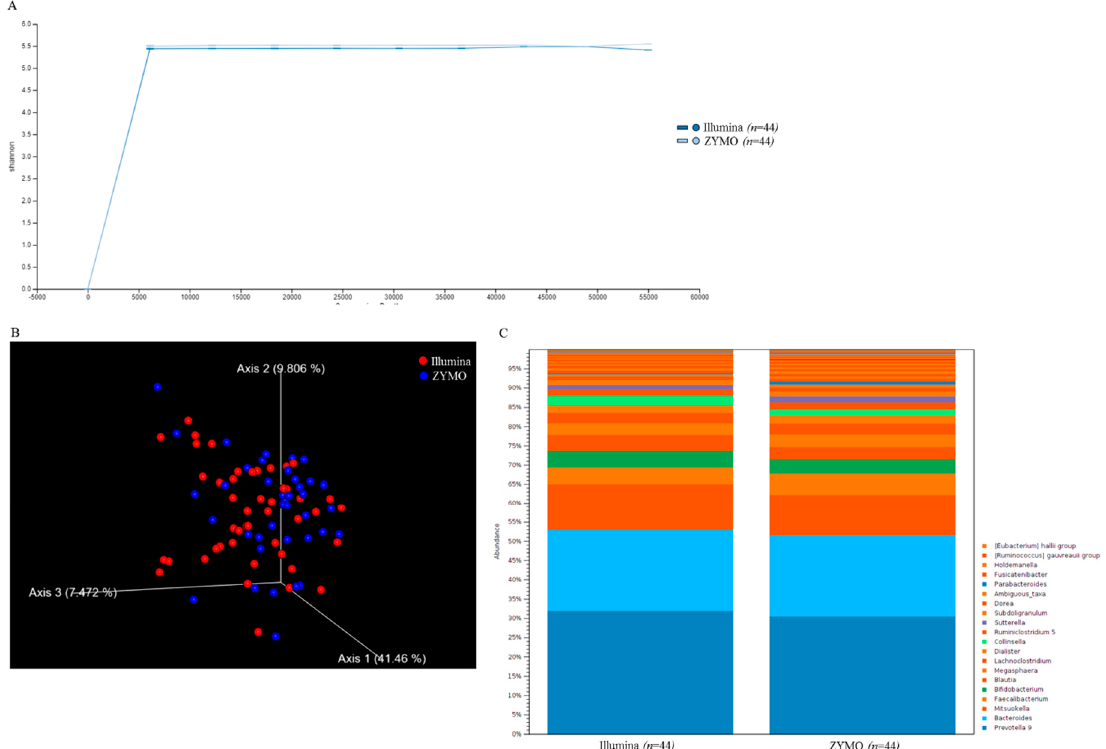
Figure 1. Diversity of taxonomic assignment was consistent between two groups of MiSeq results: ( A ) the α -diversity in two groups of MiSeq data were illustrated using Shannon indices. ( B ) Weighted Unifrac principal component analysis (PCA) was conducted to evaluate the β -diversity indices in two groups of MiSeq data; and ( C ) the relative abundances of top 20 classified OTUs in two groups of MiSeq data are shown in stacked bar chart.